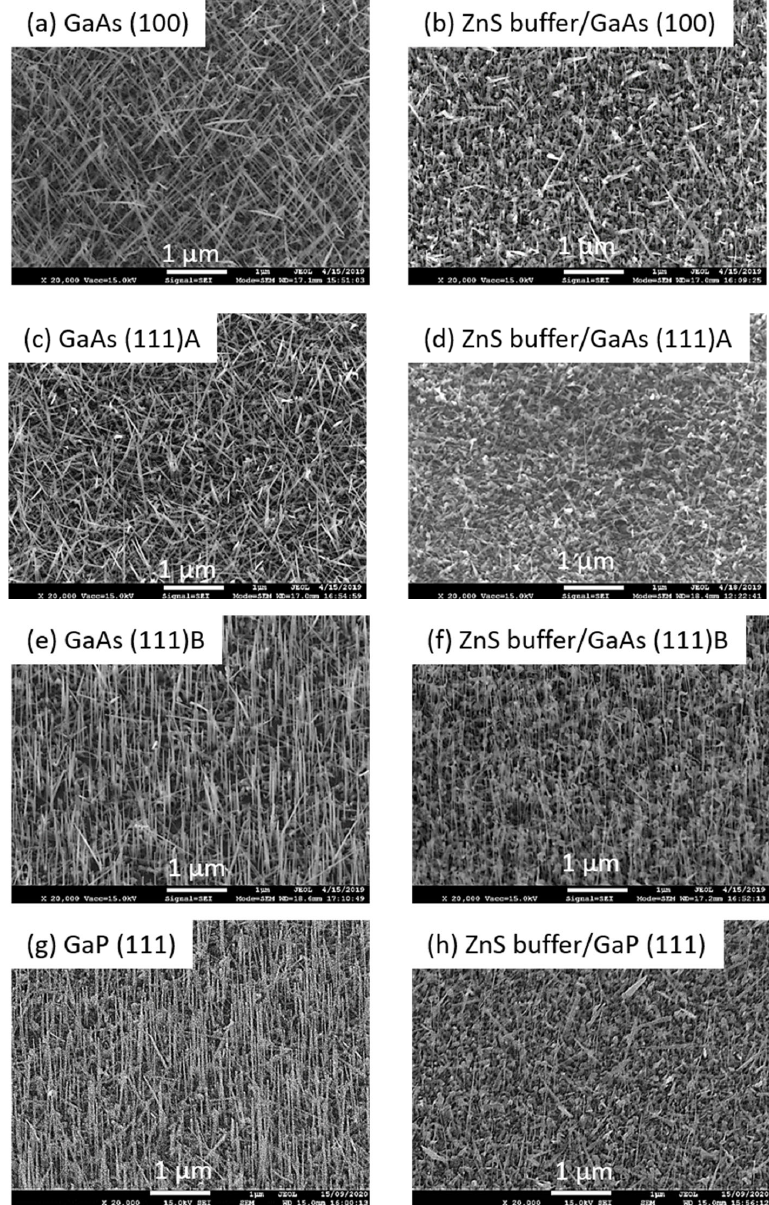
Figure 7. 45° tilted SEM images of ZnS NWs grown on: ( a ) GaAs (100), ( b ) ZnS/GaAs (100), ( c ) GaAs (111)A, ( d ) ZnS/GaAs (111)A, ( e ) GaAs (111)B, ( f ) ZnS/GaAs (111)B, ( g ) GaP (111), and ( h ) ZnS/GaP (111).